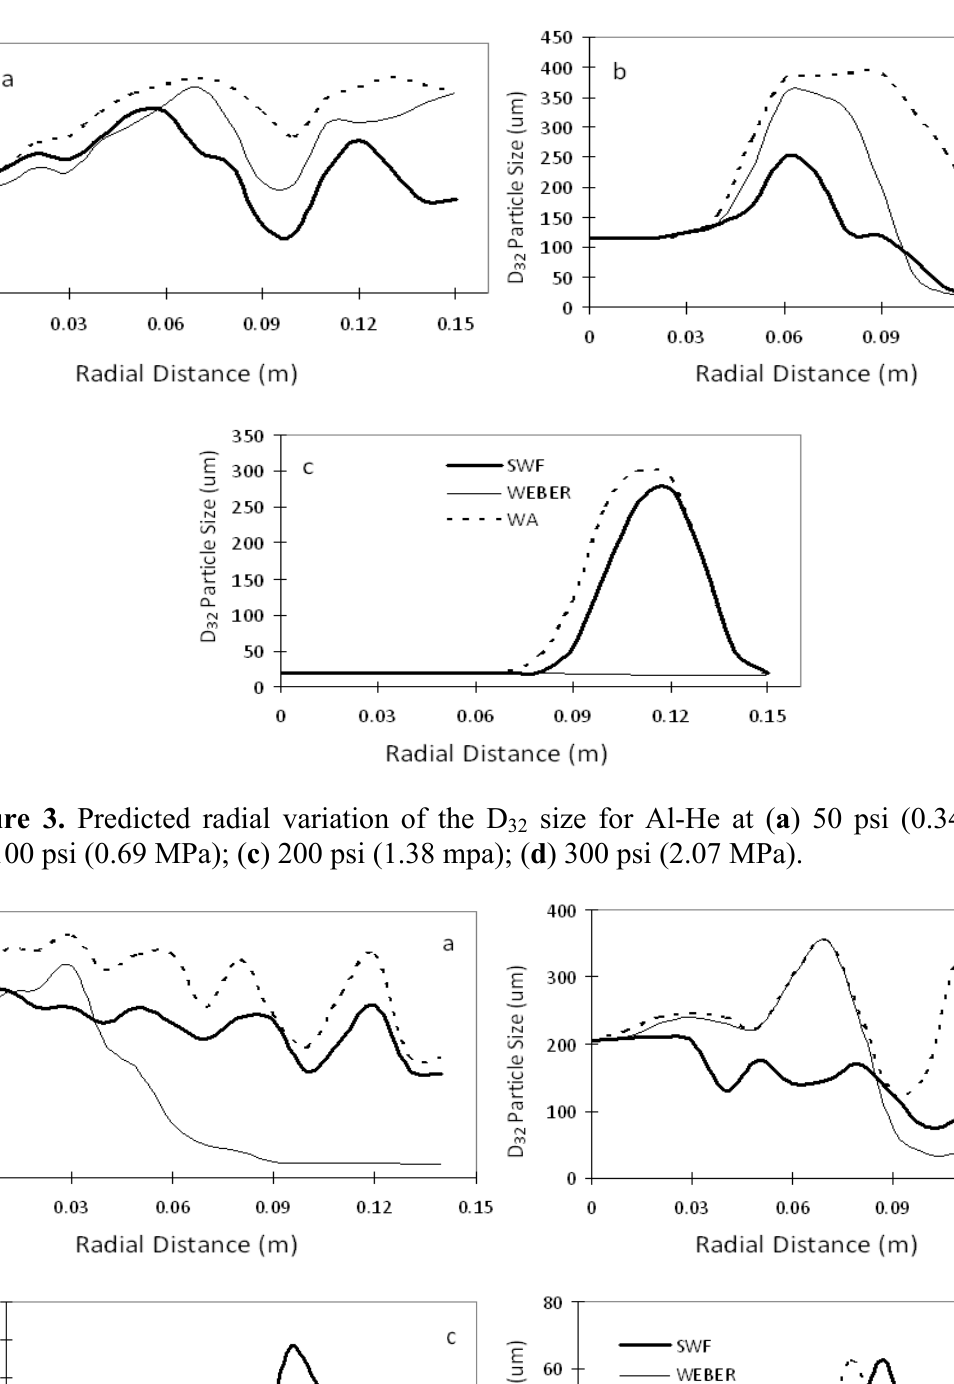
Figure 2. Predicted radial variation of the D ( b ) 200 psi (1.38 mpa); ( c ) 300 psi (2.07 MPa).